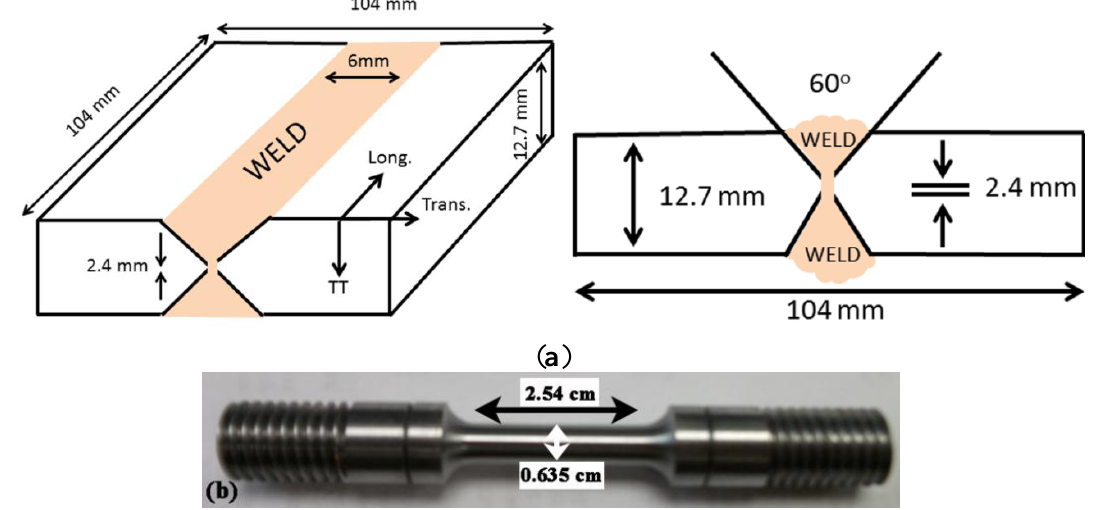
Figure 2. ( a ) Schematic representation of the double V-butt welded plate; and ( b ) specimen used for creep testing. The specimen is cut from the plate, and the central portion of the specimen matches the weld